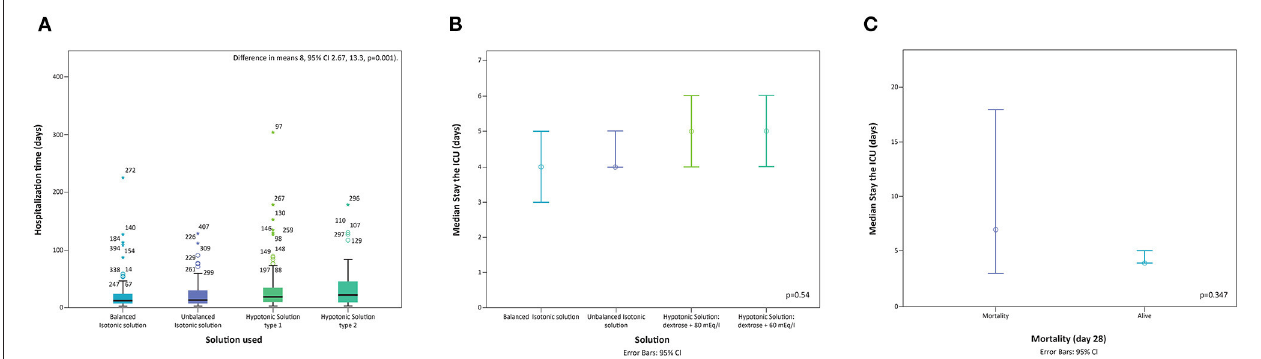
FIGURE 2 | Length of stay in hospital and type of solution used. textbf(A) Distribution of length of hospital stay by solution used. (B) Distribution of length of stay in the ICU by solution used. (C) Distribution of length of stay in the ICU in mortality cases. Navy blue: Balanced isotonic solution, Purpure: Unbalanced isotonic solution, Dark green: Hypotonic solution type 1, and Light green: Hypotonic solution type